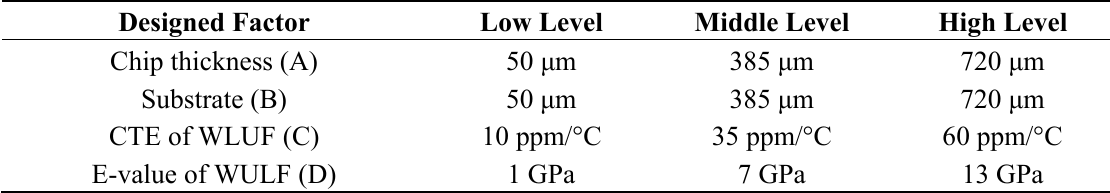
Table 5. Three levels of factorial designs for concerned factors of packaging structure with WLUF.